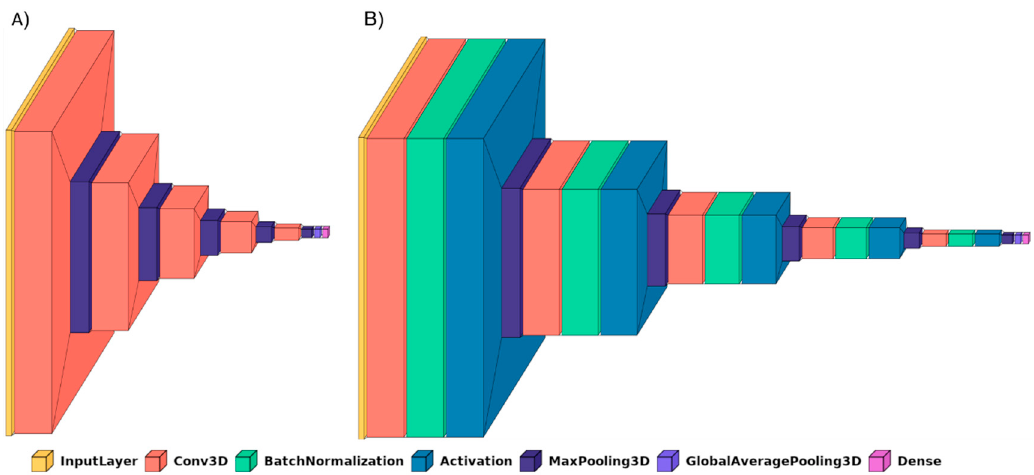
Figure 2. BrainNet3D network ( A ), and BrainNet3D network with Batch Normalization ( B ).